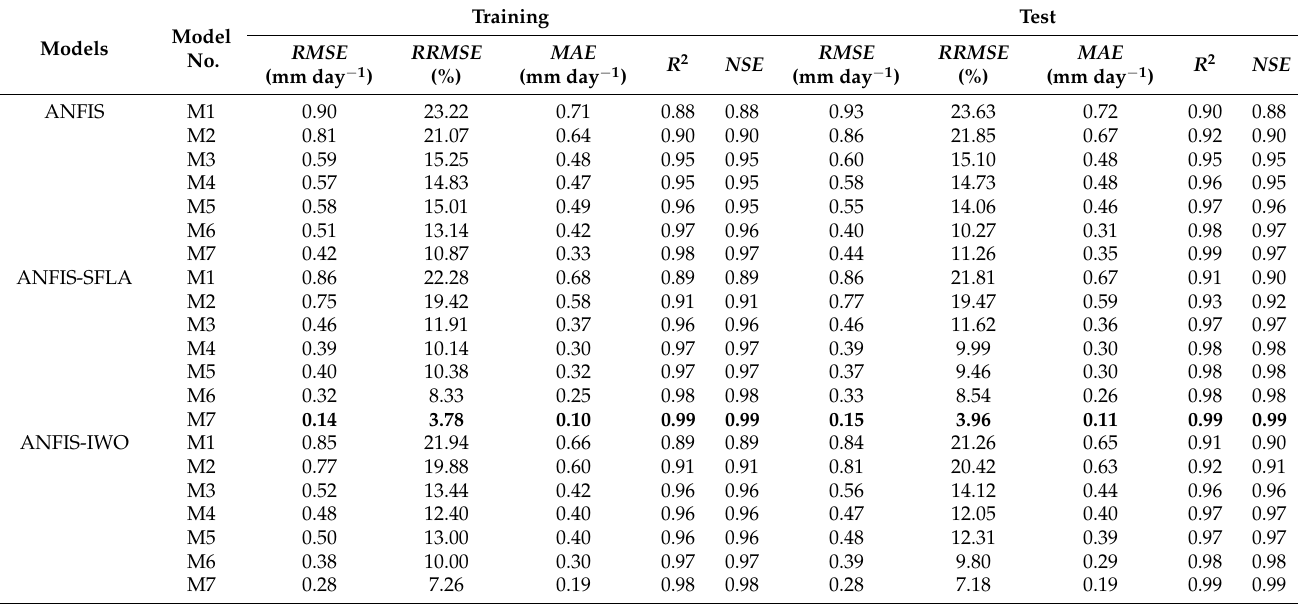
Table 5. The statistical indicators obtained for the classical ANFIS and the proposed hybrid ANFIS-SFLA and ANFIS-IWO models in estimating daily ETo vs. the standard daily ETo calculated with the FAO-56 PM method in the training and test phases (Tabriz